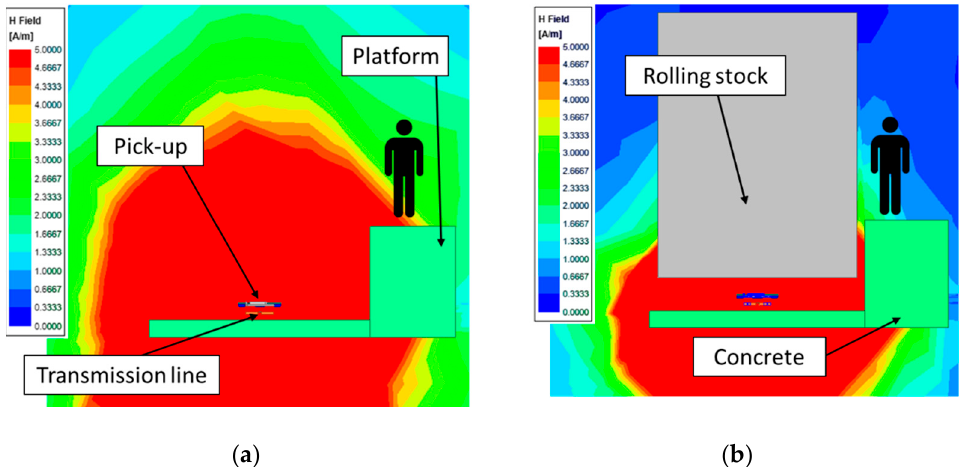
Figure 6. Magnetic field distribution in a platform ( a ) without a rolling stock and ( b ) with a rolling stock.